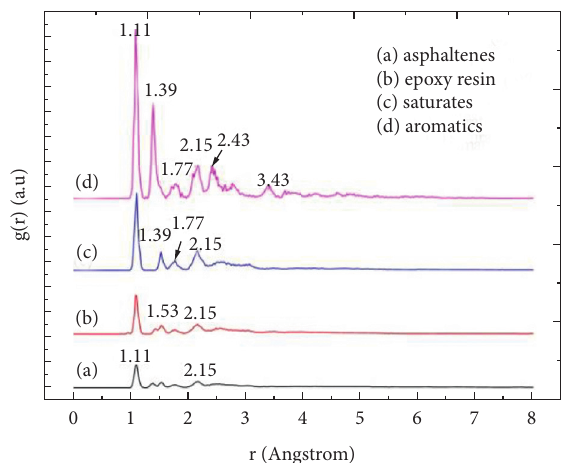
Figure 5: Radial distribution function curve of each component in epoxy bitumen